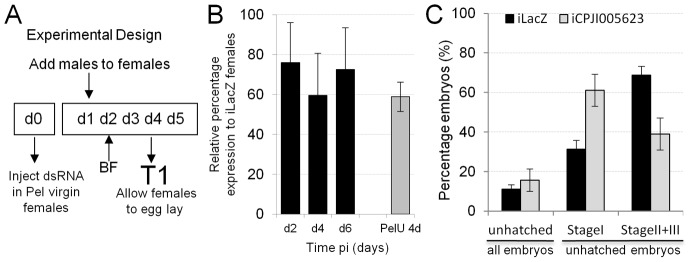
Knockdown analysis of CPIJ005623 in C. quinquefasciatus Pel females.
A. Diagram representing experimental design of knockdown (KD) experiments, d-day post pupal eclosion, BF-Blood feed, T-time point. B. KD assessment of iCPIJ005623 in Pel ovaries. Reduction of CPIJ005623 mRNA levels similar to uninfected ovaries was observed in infected ovaries when CI developmental progression was seen. C. Increased early embryo (stageI) developmental arrest is detected after iCPIJ005623 in compatible Pel male cross.